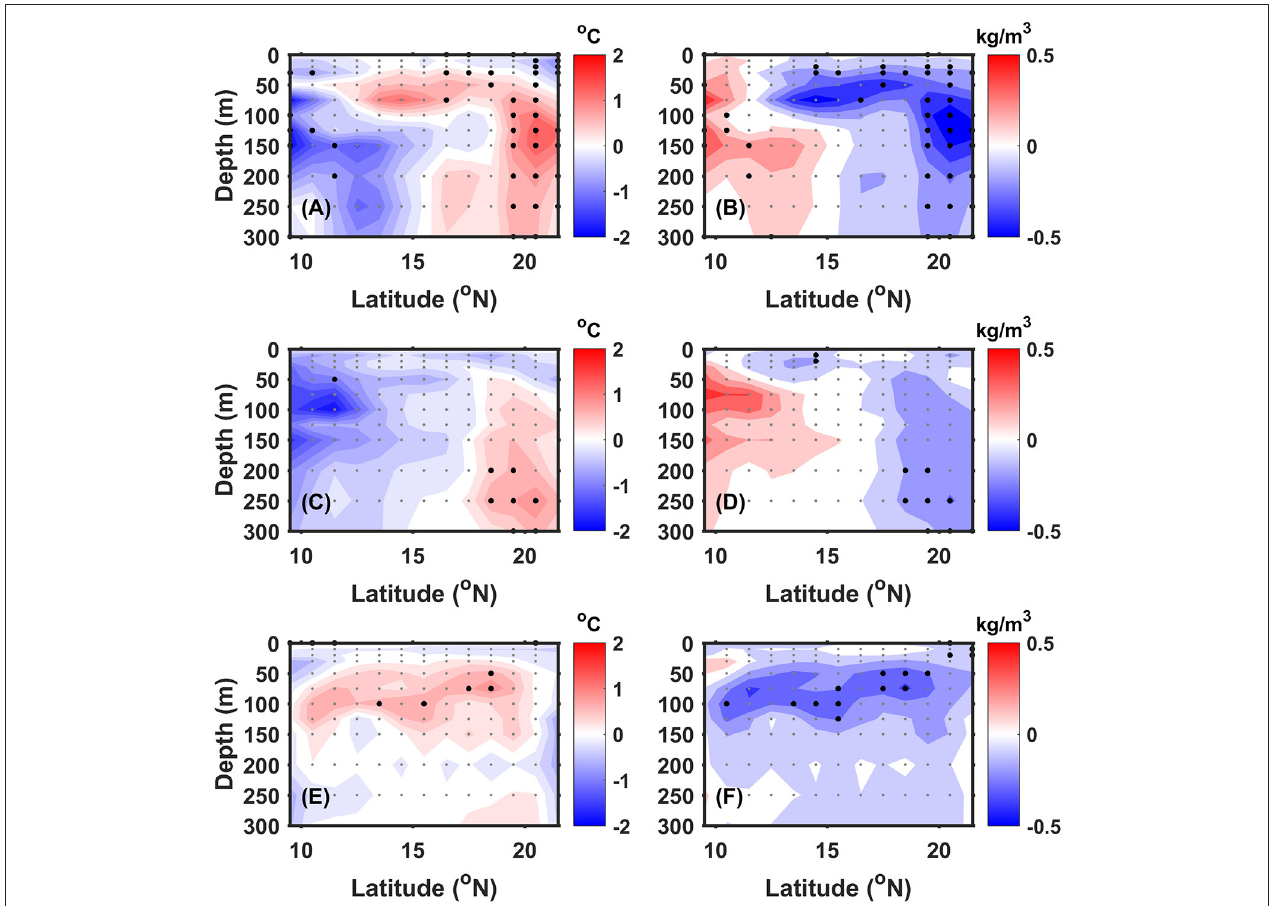
FIGURE 11 | Meridional distribution of the anomalies in temperature (left) and potential density (right) averaged within 108 ◦ E and 121 ◦ E during the month and a month before observing the ocean eddies, using the temperature-salinity (TS) gridded data of World Ocean Database version 13 (WOD13). (A,B) For the anticyclonic eddies with significant downwelling. (C,D) For the cyclonic eddies with significant upwelling. (E,F) For all the eddies without significant upwelling or downwelling. The gray dots show the data points to plot the contours, and the black dots shows the data points significant to the 95% confidence level based on t -testing. Note that the statistical analysis in (E,F) does not include the case of Argo 2902045 in May 2017 because of the data availability of TS gridded data of WOD13 up to 2014.